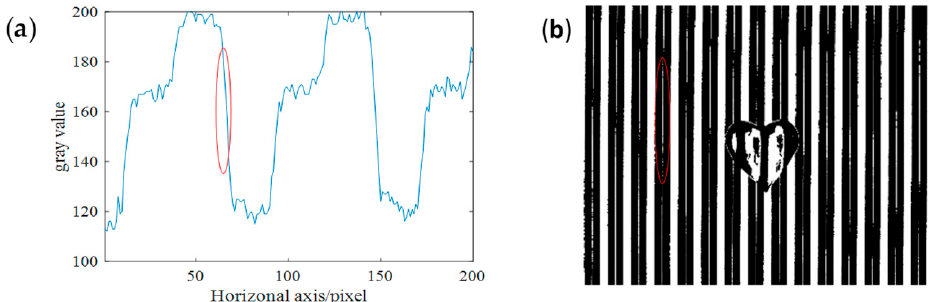
Figure 5. The optical proximity effect (OPE) on the boundary of the period of the deformed pattern: ( a ) the gray value distribution on the boundary of the period of the deformed pattern; and ( b ) the inaccurate segmentation of the deformed pattern.